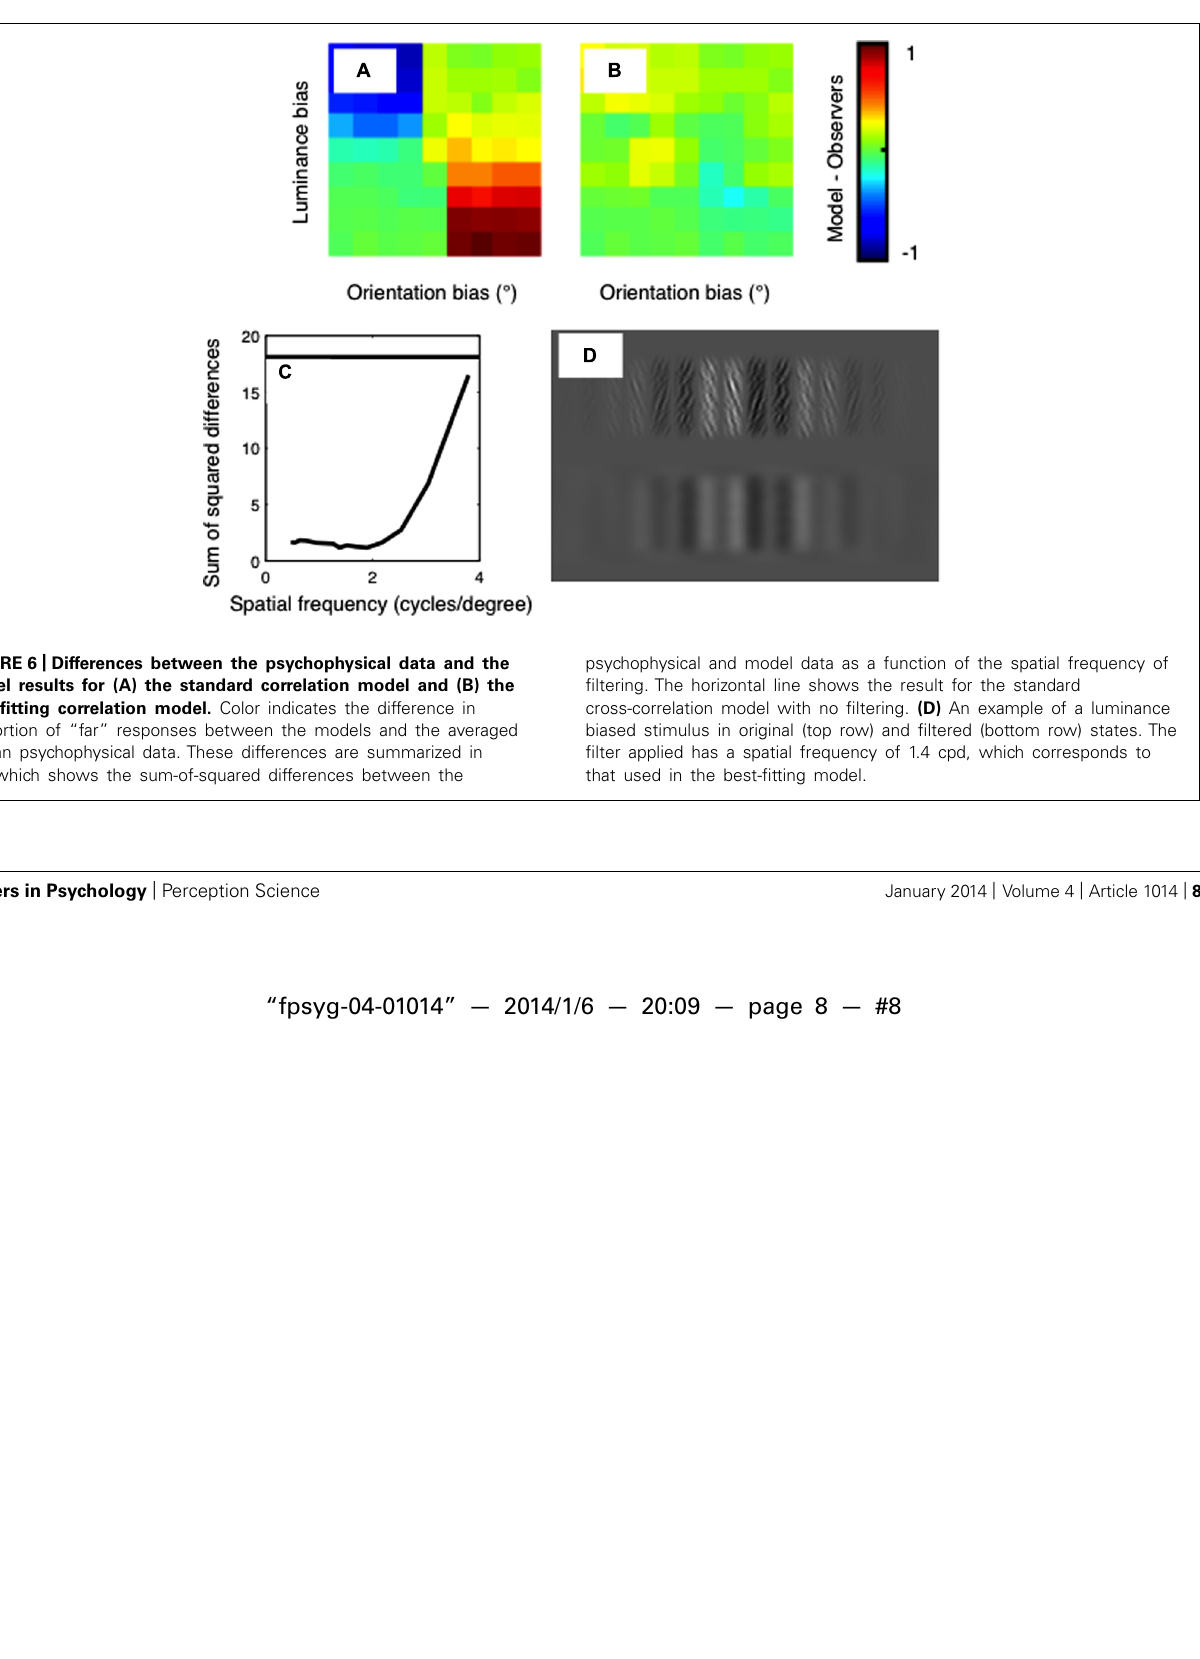
psychophysical and model data as a function of the spatial frequency of filtering. The horizontal line shows the result for the standard cross-correlation model with no filtering. (D) An example of a luminance biased stimulus in original (top row) and filtered (bottom row) states. The filter applied has a spatial frequency of 1.4 cpd, which corresponds to that used in the best-fitting